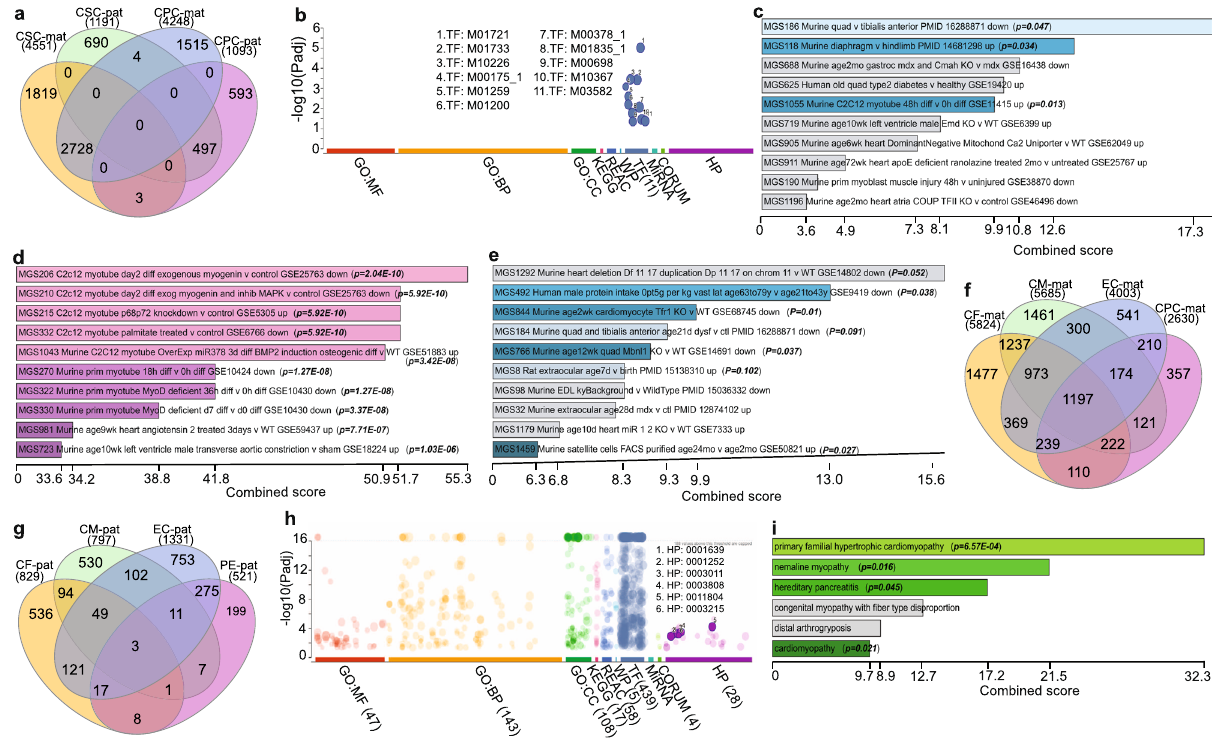
Fig. 4 | Critical cardiac genes are DeMA. a Intersects of mat-mono and pat-mono genesinCPCandCSCcells. b Functionalpro fi lesofCPCpat-monogenes.588outof 592 CPC pat-mono genes are only enriched in TF functional pro fi le